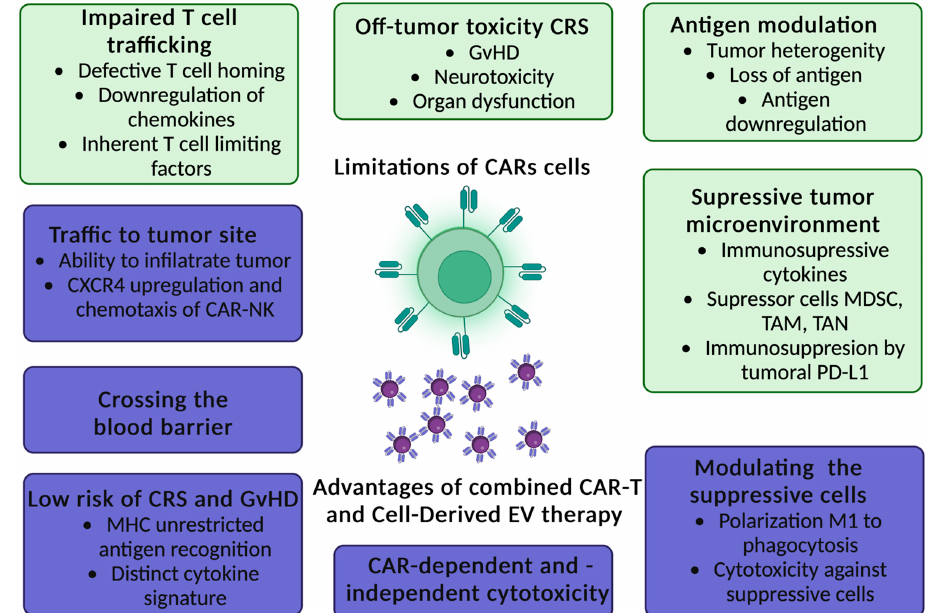
Int. J. Mol. Sci. 2022 , 23 , x FOR PEER REVIEW